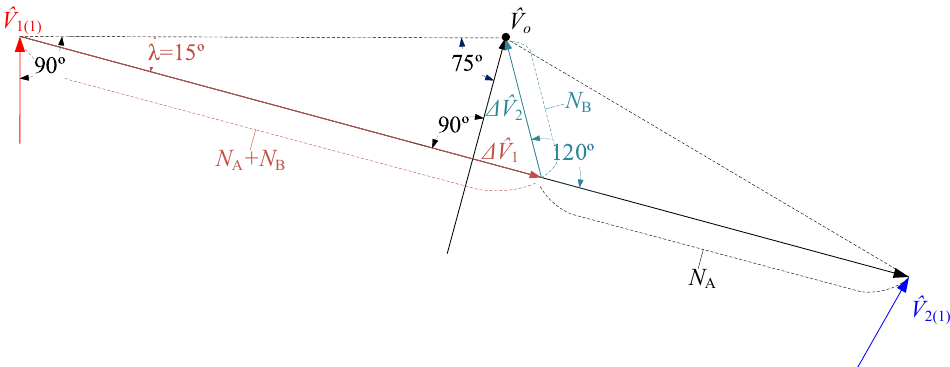
Figure 3. Desirable positions of basic output vectors of component inverters in the 12-pulse modular VSI.